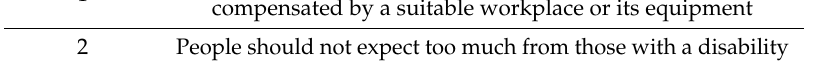
Table A3. Distribution of the answers to questions used to define Ambassador’s attitude. People Should Not Expect Too Much from Those with a